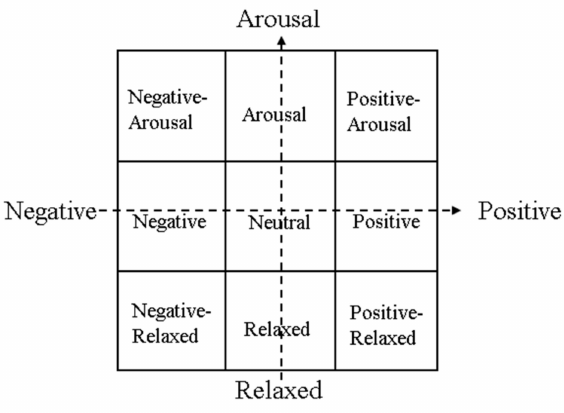
Figure 1. Produced valence–arousal emotion model with neutral emotions.